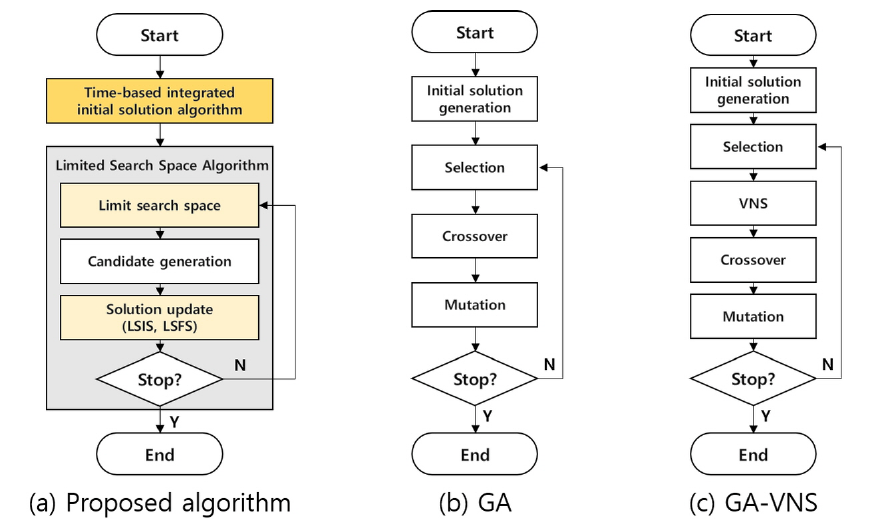
Figure 2. Flowcharts of the algorithms. ( a ) Proposed algorithm; ( b ) GA; ( c )